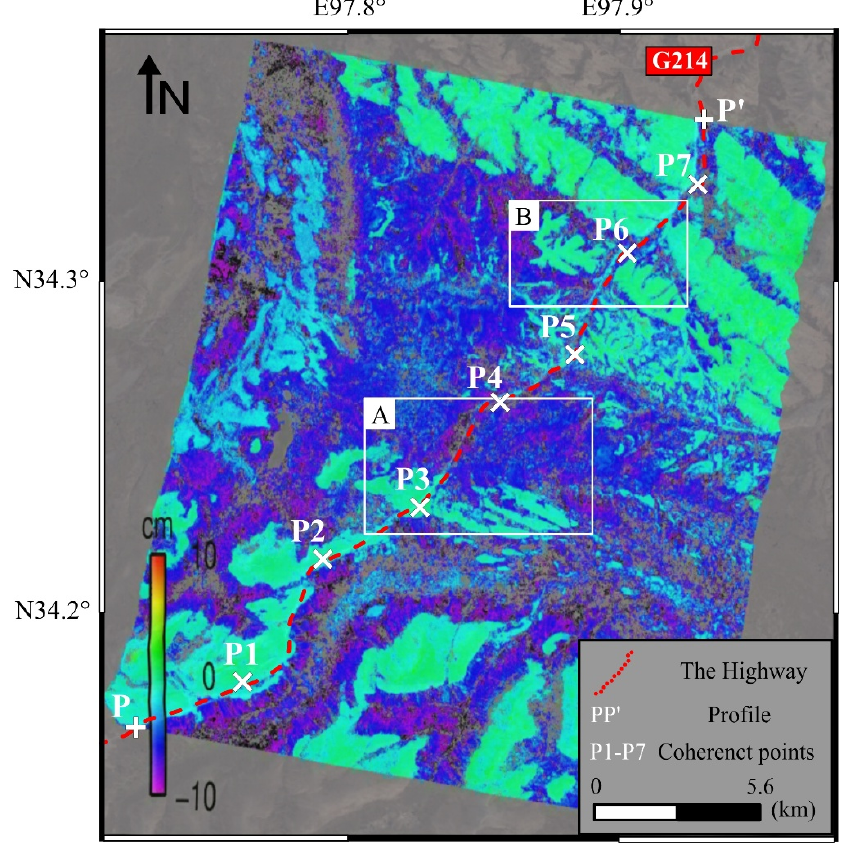
Figure 5. Accumulated subsidence map from stacking InSAR and the location of the highway, PP’,